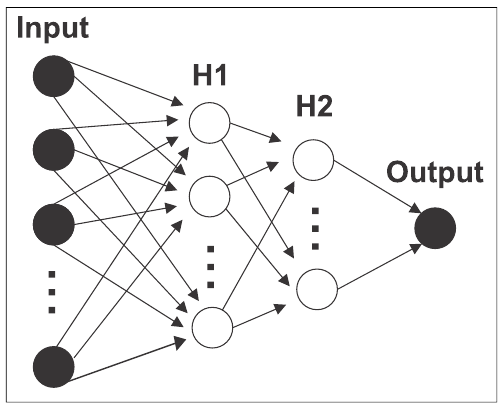
Figure 1. Fully connected feedforward MLP with two hidden